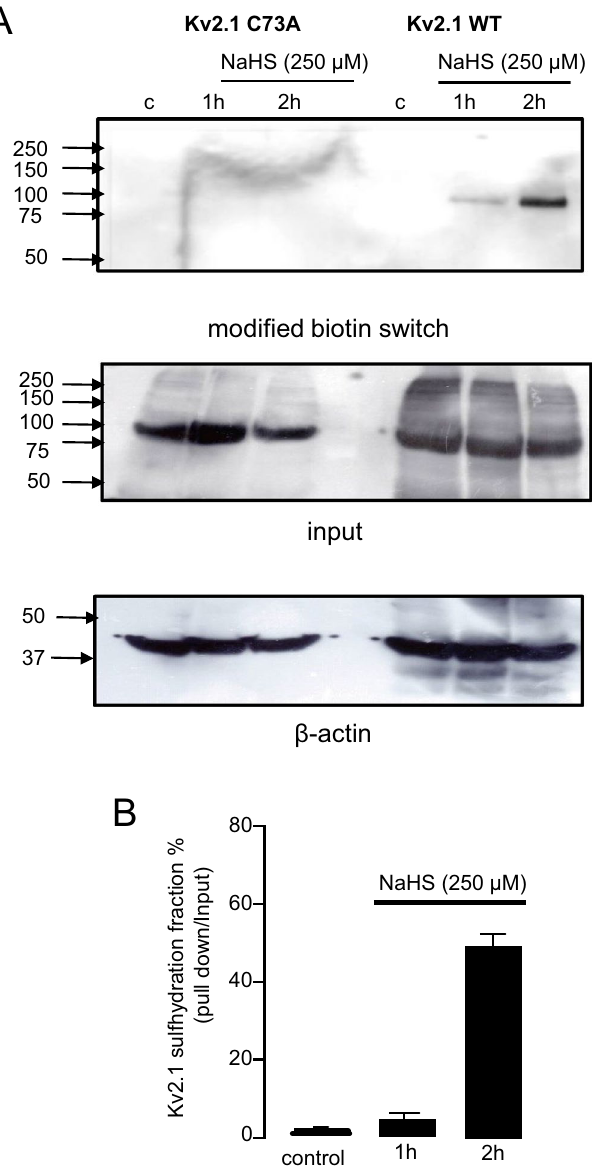
Figure 4. Kv2.1 sensitivity to NaHS is mediated by cysteine 73. ( A ) S-sulfhydration of WT but not C73A Kv2.1 by NaHS (250 µM) in HEK293 cells as detected by western blot analysis of biotinylated proteins produced by the modified biotin switch assay (upper bands). Middle bands demonstrate Kv2.1 protein input. Lower bands shows the loading control β-actin. Representative of five experimental repeats. ( B ) % fraction of S-sulfhydrated Kv2.1 following modified biotin switch assay over a 2 h